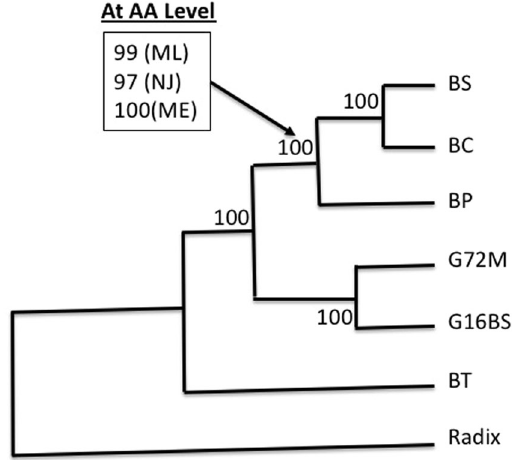
Figure 6. A consensus phylogenetic tree was constructed using whole mtDNA nucleotide sequence and aa sequences of all 13 PCG combined. Three methods, ML, NJ and ME, were used to build the tree. For the whole mtDNA sequences, the three trees are identical in terms of topology and bootstrap values (all with 100). For aa sequences, the topology is exactly the same as that was built by nt sequences. The bootstrap values are almost the same except for one node that is highlighted in the box. GenBank accession numbers for B. tenagophila (BT) and Radix auricularia are EF433576 and NC_026538, respectively. Please note that due to gene